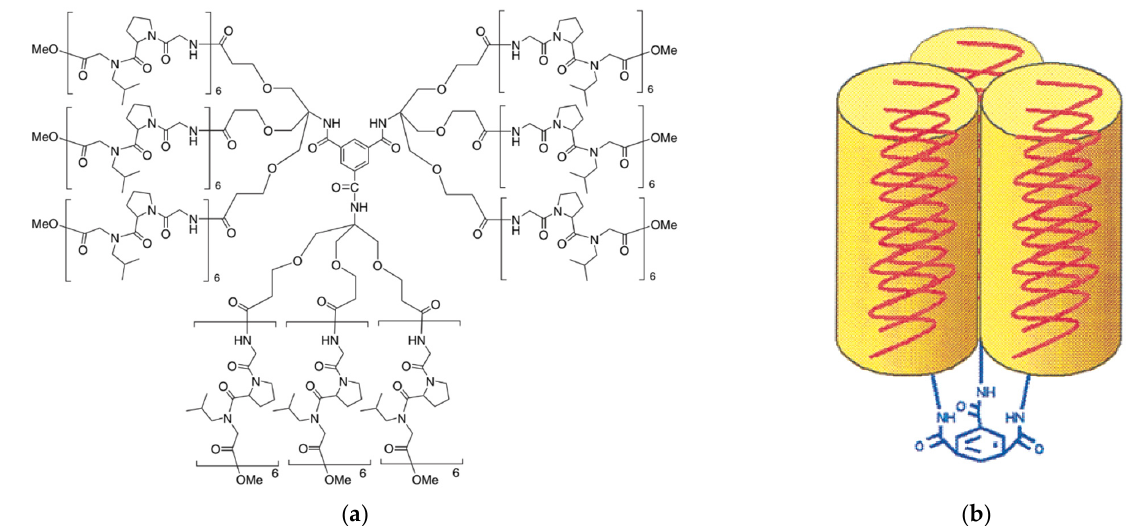
Figure 3. ( a ) The collagen mimetic dendrimer TMA[TRIS[(Gly-Pro-Nleu) 6 -OMe] 3 ] 3 . ( b ) Triple helices conformation of the amino acid clustering emanating from the trimesic acid core, both reproduced with permission from [119]. Copyright: American Chemical Society.